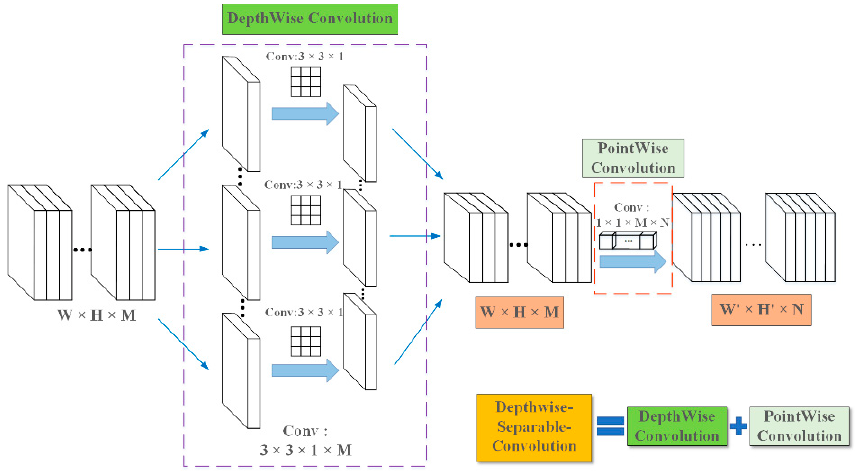
Figure 5. Depth-wise separable convolution structure.